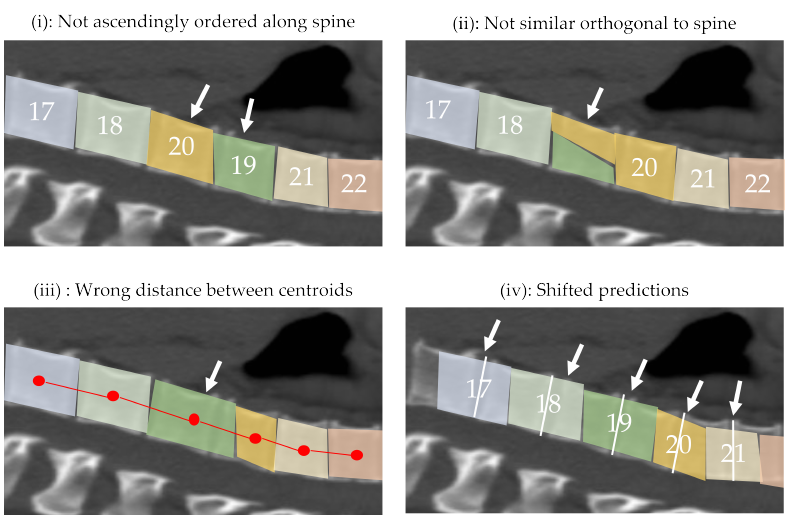
Figure 2. 2-way training process of the Detection module: In step one, L1 distance is used to calculate the loss of a mini-batch of source domain samples. In step two, several “sanity checks” (see Figure 3 for an overview) are calculated to form the loss of a mini-batch of target-domain data. The sanity- check-based DSL loss only considers spine pixels by multiplying the output of the Identification module with the output of the Detection module and employs the Felzenszwalb-Huttenlocher algorithm [26] to create a weak segmentation mask of vertebrae location in an unsupervised way (c.f. Section 3.2).